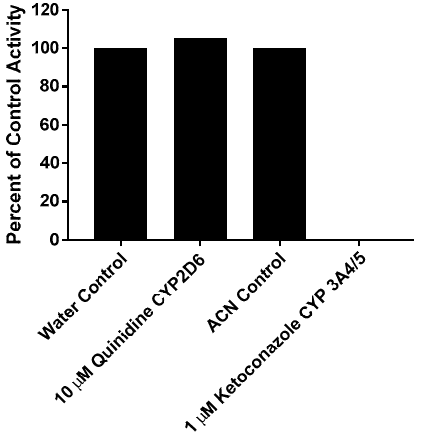
Figure 3. Effect of direct-acting chemical inhibitors on the loss of CRV431 (1 μ M) by human liver microsomes.